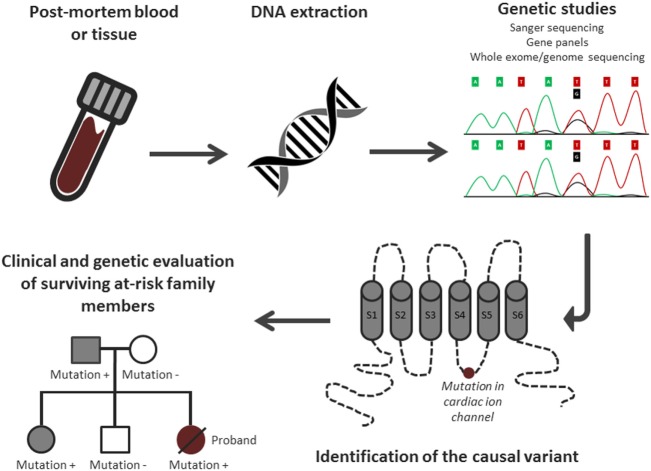
Overview of the molecular autopsy process. Adjusted from Semsarian et al. (3) with permission of the publisher.